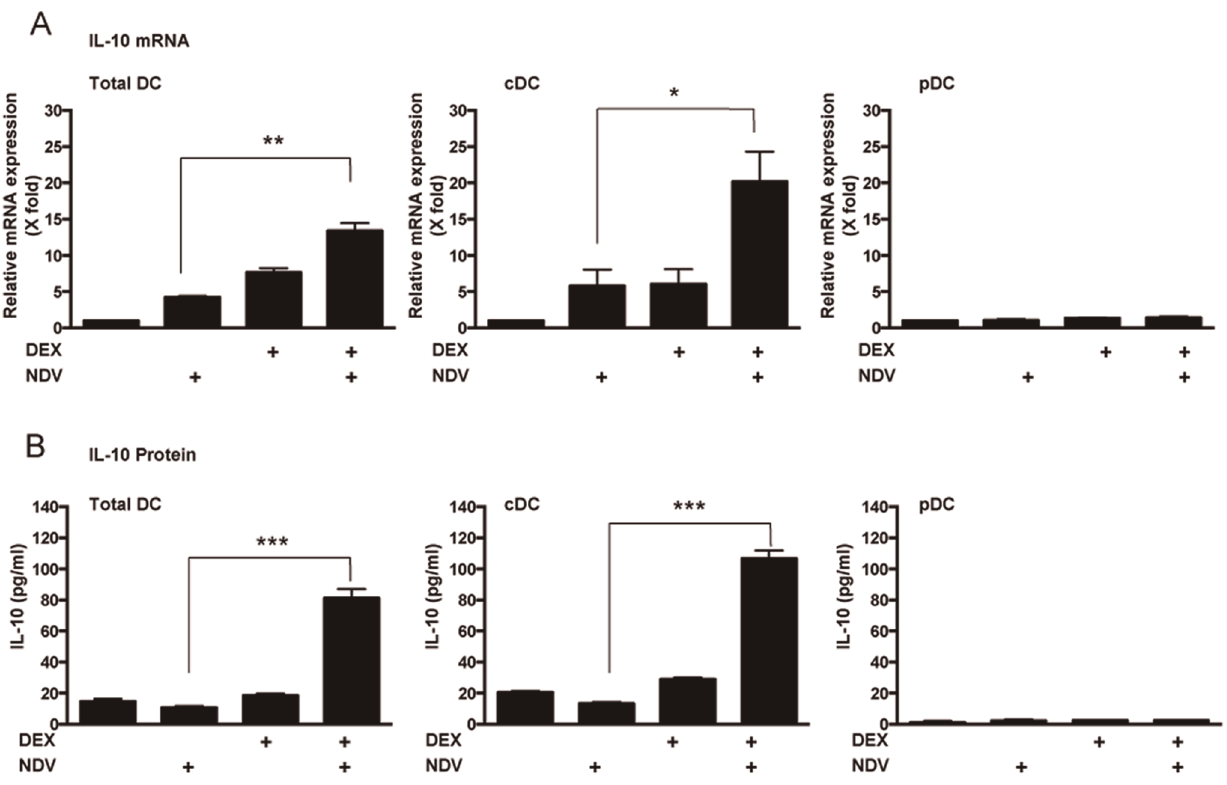
Figure 3. cDCs, but not pDCs, are the major DC subtype for production of IL-10 upon DEX treatment and/or NDV infection in the FLT3L-derived DCs. FLT3L-derived DCs were sorted into cDC and pDC subpopulation. They were individually pre-treated with DEX (10 2 6 M) for 30 min, infected with NDV for 24 hours, and IL-10 mRNA expression ( A ) and IL-10 protein expression ( B ) were measured. Bars represent means and standard errors of fold changes of the IL-10 mRNA expression and protein concentrations in the culture media obtained from three independent experiments. *: p , 0.05, **: p , 0.01, ***: p , 0.001, compared the 2 conditions indicated. (Figure 7C). It is known that several serine/threonine kinases phosphorylate GR at serine residues located in its N-terminal domain (such as those at amino acid position 203, 211 and 226 of the human GR, and 213, 220 and 235 of the mouse GR), and modulate GR-induced transcriptional activity [19,39]. We there- fore expressed mutant human GRs defective in these serines together with ERK2, and found that replacement of serine 203 with alanine completely abolished ERK2-mediated enhancement of DEX-stimulated IL-10 promoter activity (Figure 7D). In contrast, ERK2 was still active on the transcriptional activity of the mutant human GRs defective in serine 211 or 226 (data not shown). We further found that ERK2 D319N enhanced DEX- induced phosphorylation of wild type human GR, but not of the mutant GR defective in serine 203 in HCT116 cells (Figure 7E). NDV infection also enhanced GR phosphorylation in a DEX treatment-dependent fashion in RAW264.7 cells, while transfec- tion of ERK1/2 siRNAs abolished NDV-induced phosphorylation of mouse GR at serine 213 (Figure 7F). These results indicate that the ERKs activated by NDV infection, and subsequent phosphor- ylation of GR by these kinases [at serine 203 (human) and 213 (mouse)] mediate the cooperative stimulation of IL-10 expression by NDV and DEX.